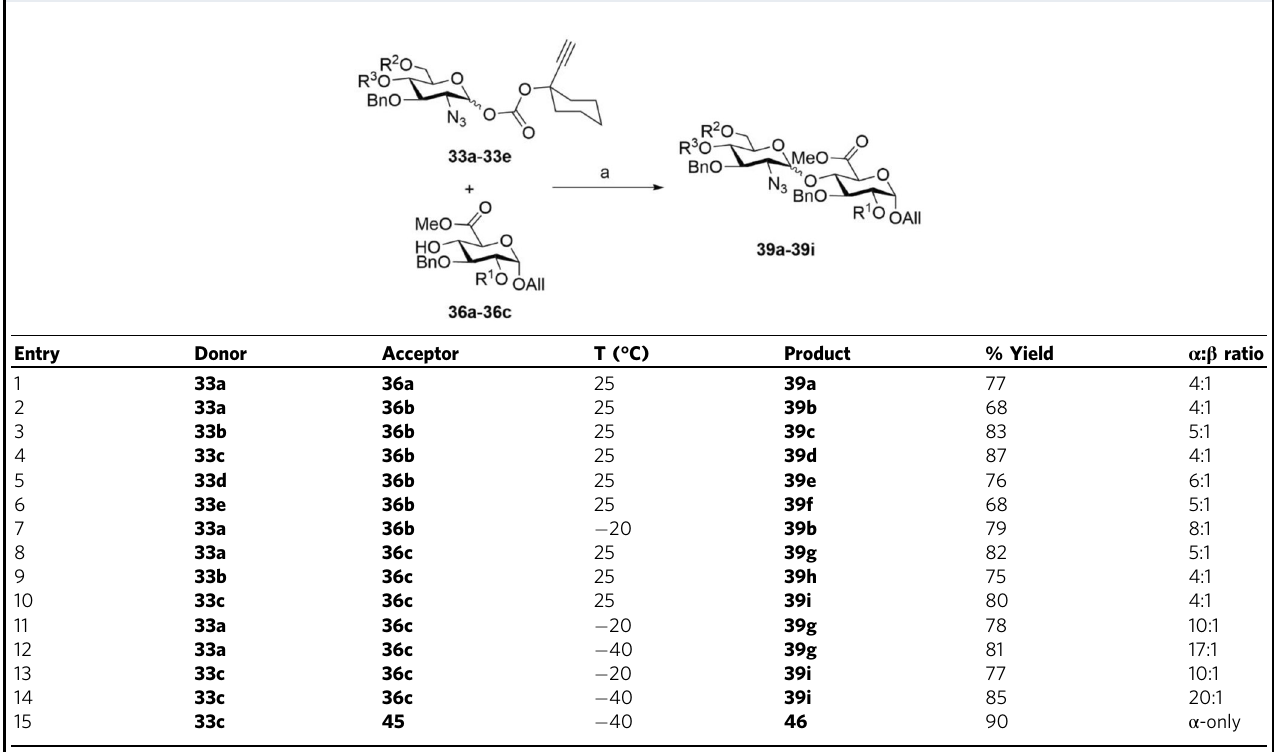
Table 1 Stereoselective synthesis of D – E disaccharide.